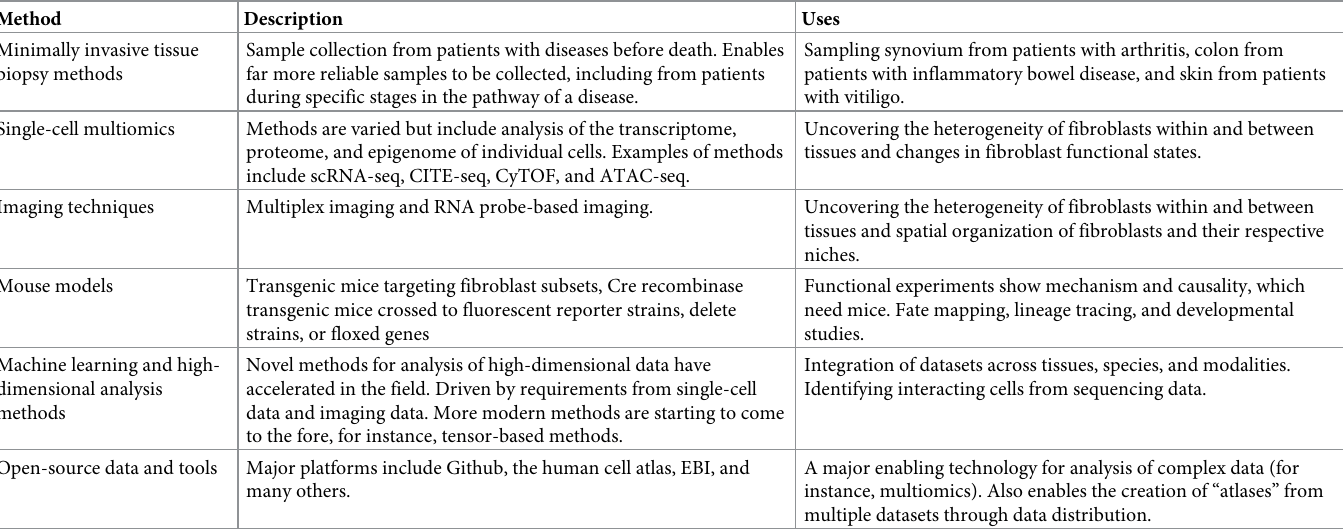
Table 1. Key technologies that enable the study of